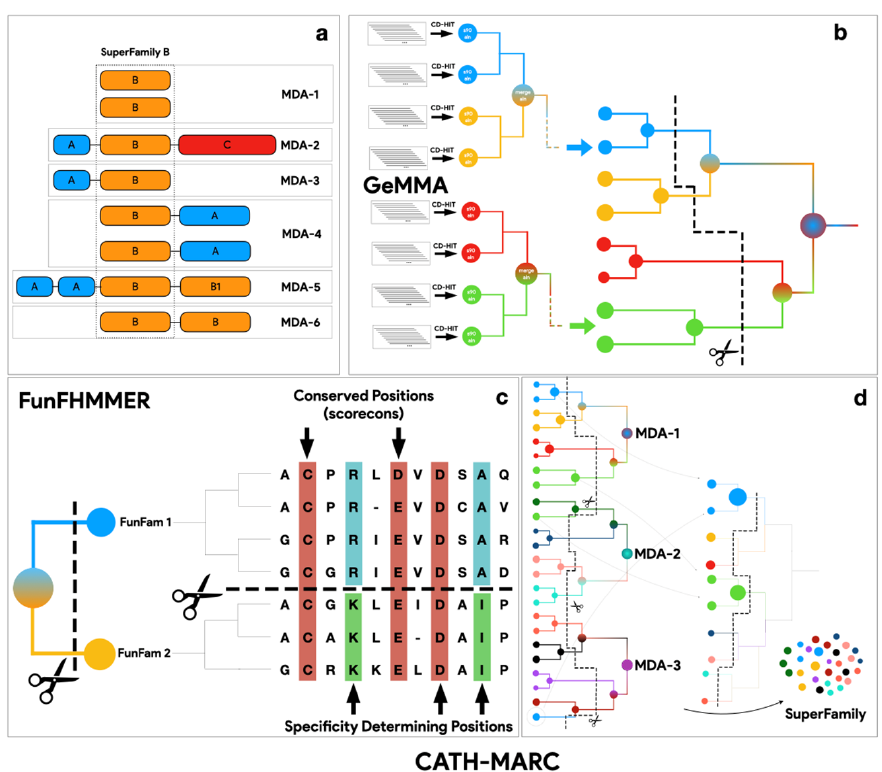
Figure 2. FunFam-MARC protocol. ( a ). FunFam-MARC approach based on multi domain architectures, ( b ). Overview of GeMMA/FunFHMMER protocol, ( c ). Example of FunFHMMER detection of specificity determining positions, ( d ). Multiple iterations of GeMMA/FunFHMMER with MDA pooling.